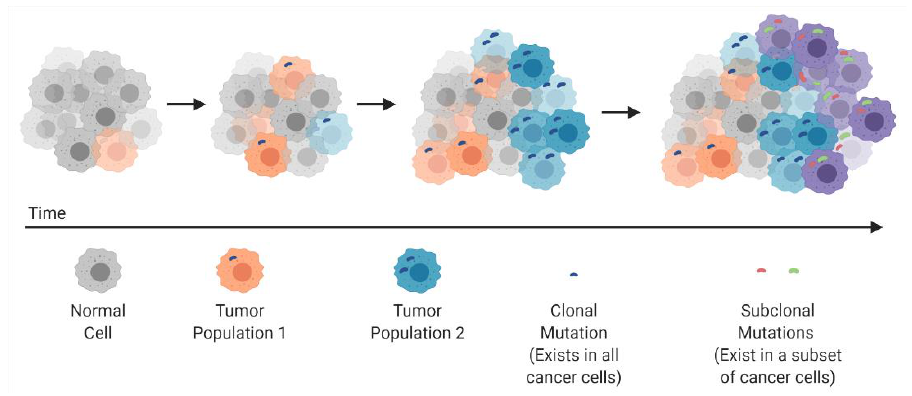
Figure 1. Clonal evolution and development of tumor heterogeneity see correct label positioning (not inside figures).